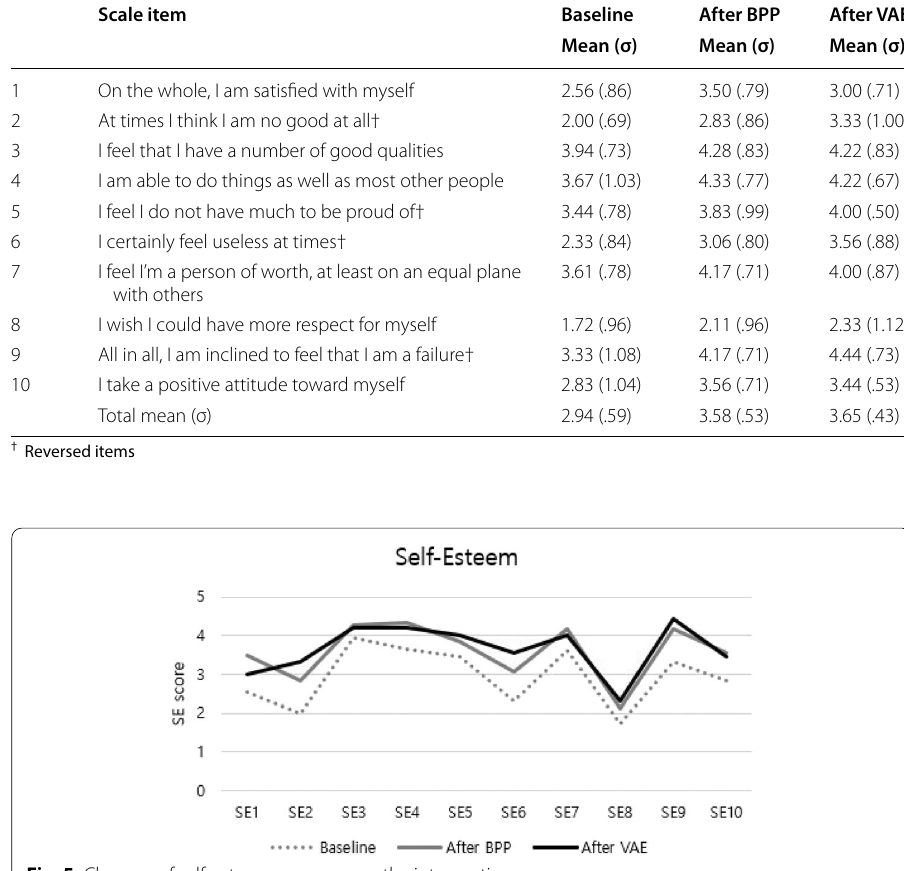
Fig. 5 Changes of self-esteem scores across the intervention